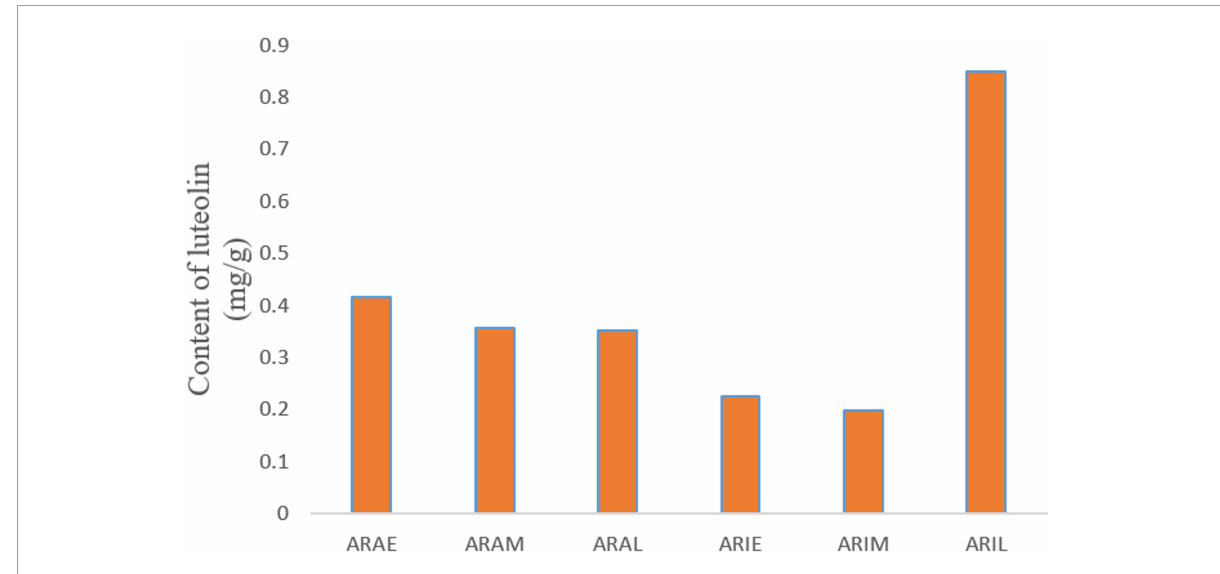
FIGURE10 Diagram of luteolin content. X-axis is the sample name, and Y-axis is the content of luteolin in the sample powder.